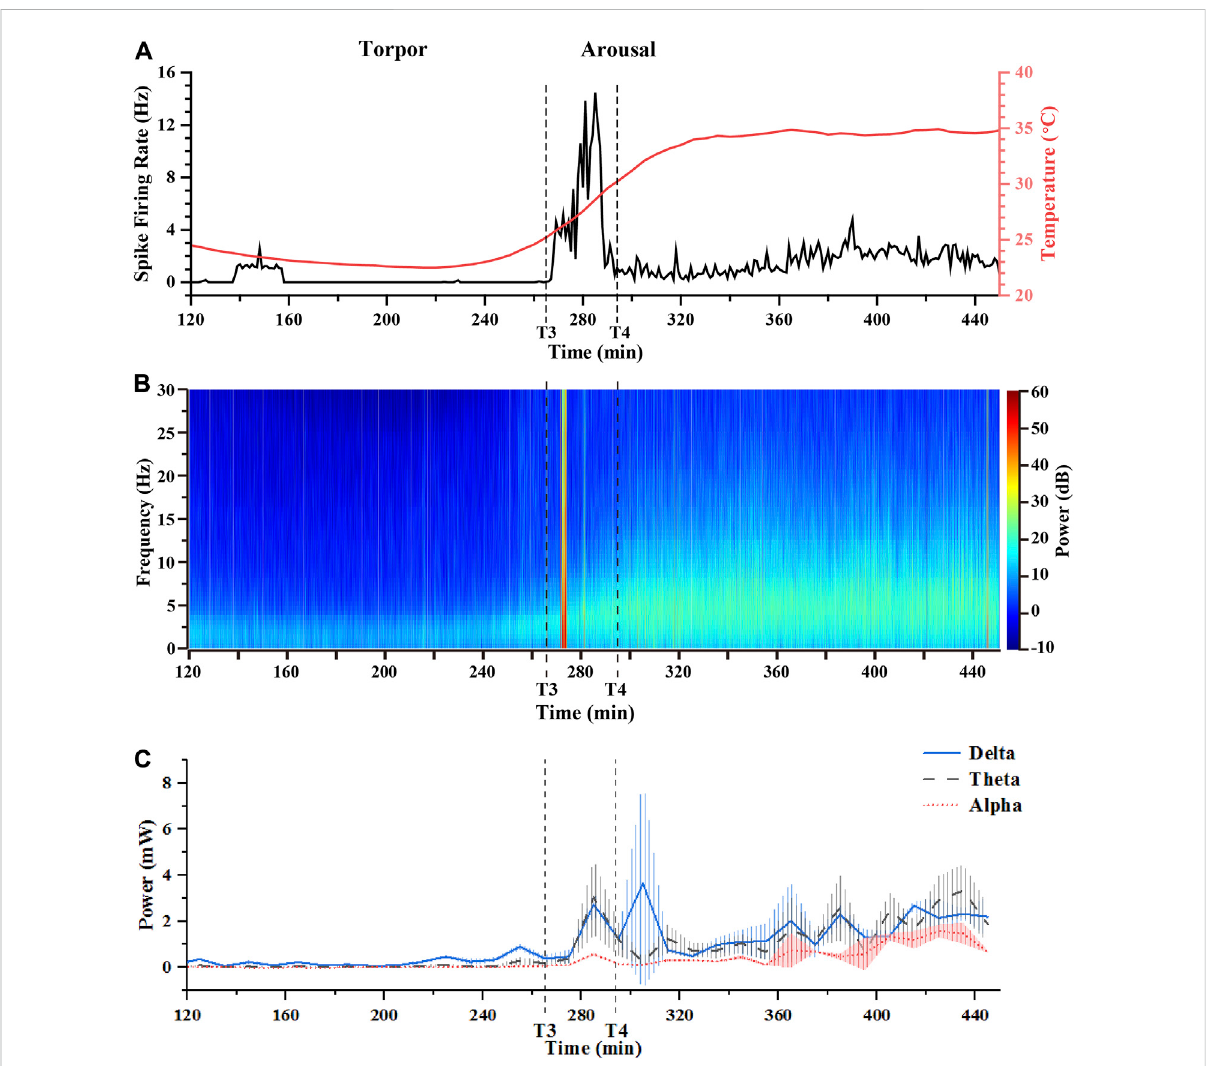
FIGURE 6 Conjoint analysisofspike fi ringrates, core body temperature, andLFPs power inthearousal period. (A) Thereal-time spike fi ring ratesand core body temperature varied from the torpor to the arousal period. (B) The real-time power analysis of LFPs with 30 Hz from the torpor to the arousal period. (C) The power of LFPs in different frequency bands ( δ , θ , α ) from the torpor to the arousal period (T3: 264 min, T4: 290 min